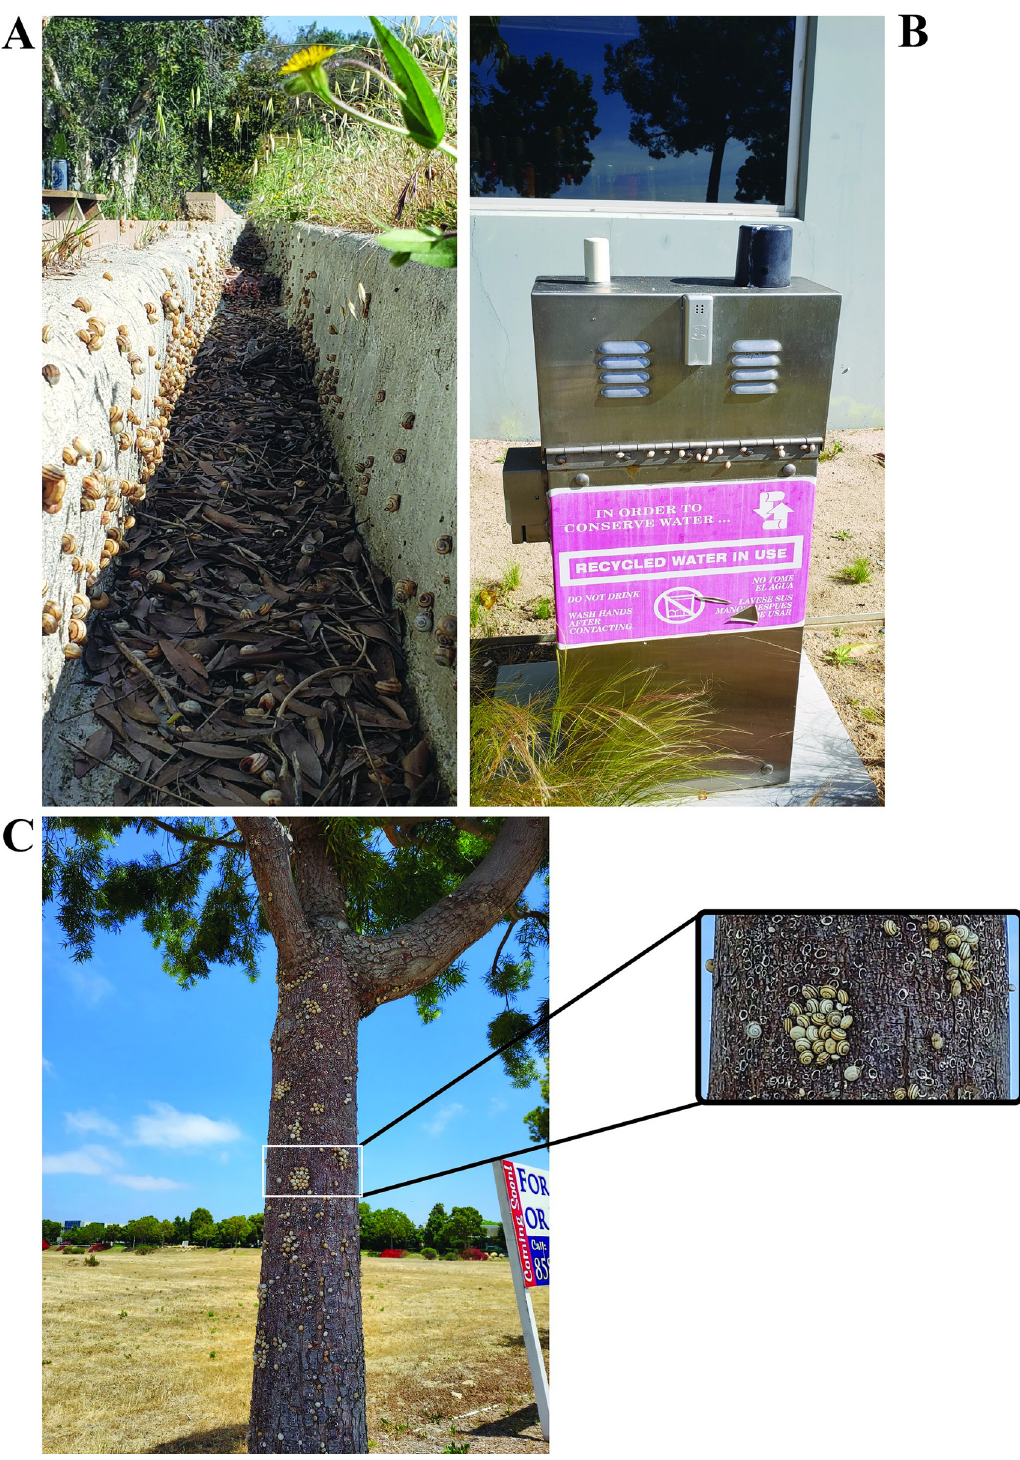
Fig 1. A gutter cluttered with Theba pisana behind a local business in Oceanside, CA (A). A utility box covered with aestevating T . pisana beside a local business in Oceanside, CA (B). Clusters of aestivating T . pisana on a tree beside a sidewalk in Oceanside, CA (C).